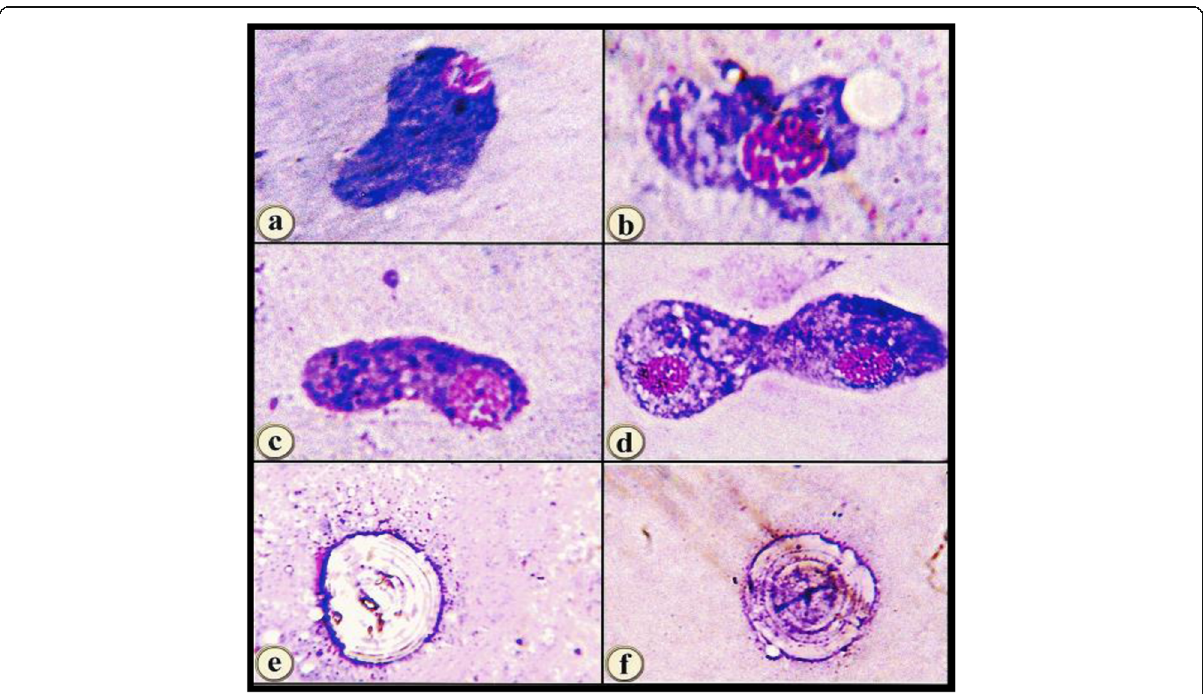
Fig. 9 Response of the hemocytes to the nematodes ’ treatments: a and b phagocytosis, c and d mitotic division, and e and f encapsulation of foreign body. ( x = 1600)